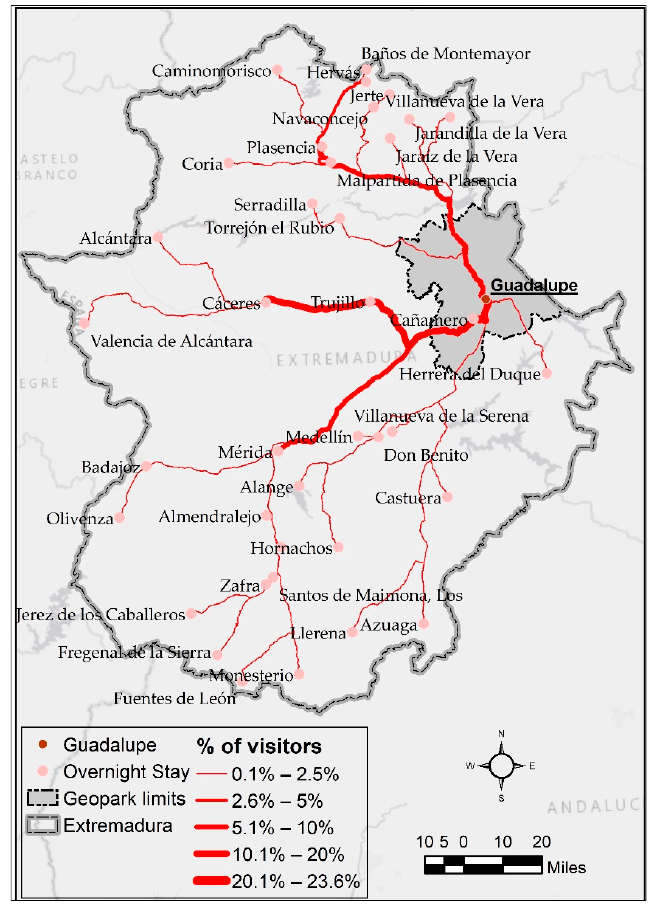
Figure 5. Percentage of visitors traveling from the overnight stay locations.